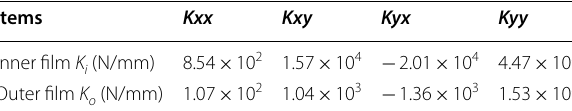
Table 2 Bearing stiffness coefficients Items